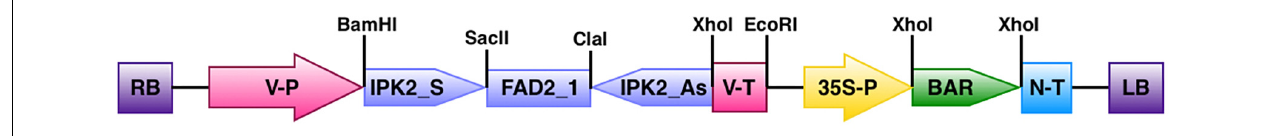
FIGURE 1 | Map showing the T-DNA region of binary vector pCWAK-ipk2. RB: right border; V-P: vicilin promoter; IPK2_S: IPK2 sense fragment; FAD2_1: fatty acid oley1 (cid:49) 12 desaturase gene intron; IPK2_AS: IPK2 antisense fragment; V-T: vicilin terminator; 35S-P: cauliflower mosaic virus 35S promoter; BAR: bialaphos resistance gene; N-T: nopaline synthase terminator; LB: left border.